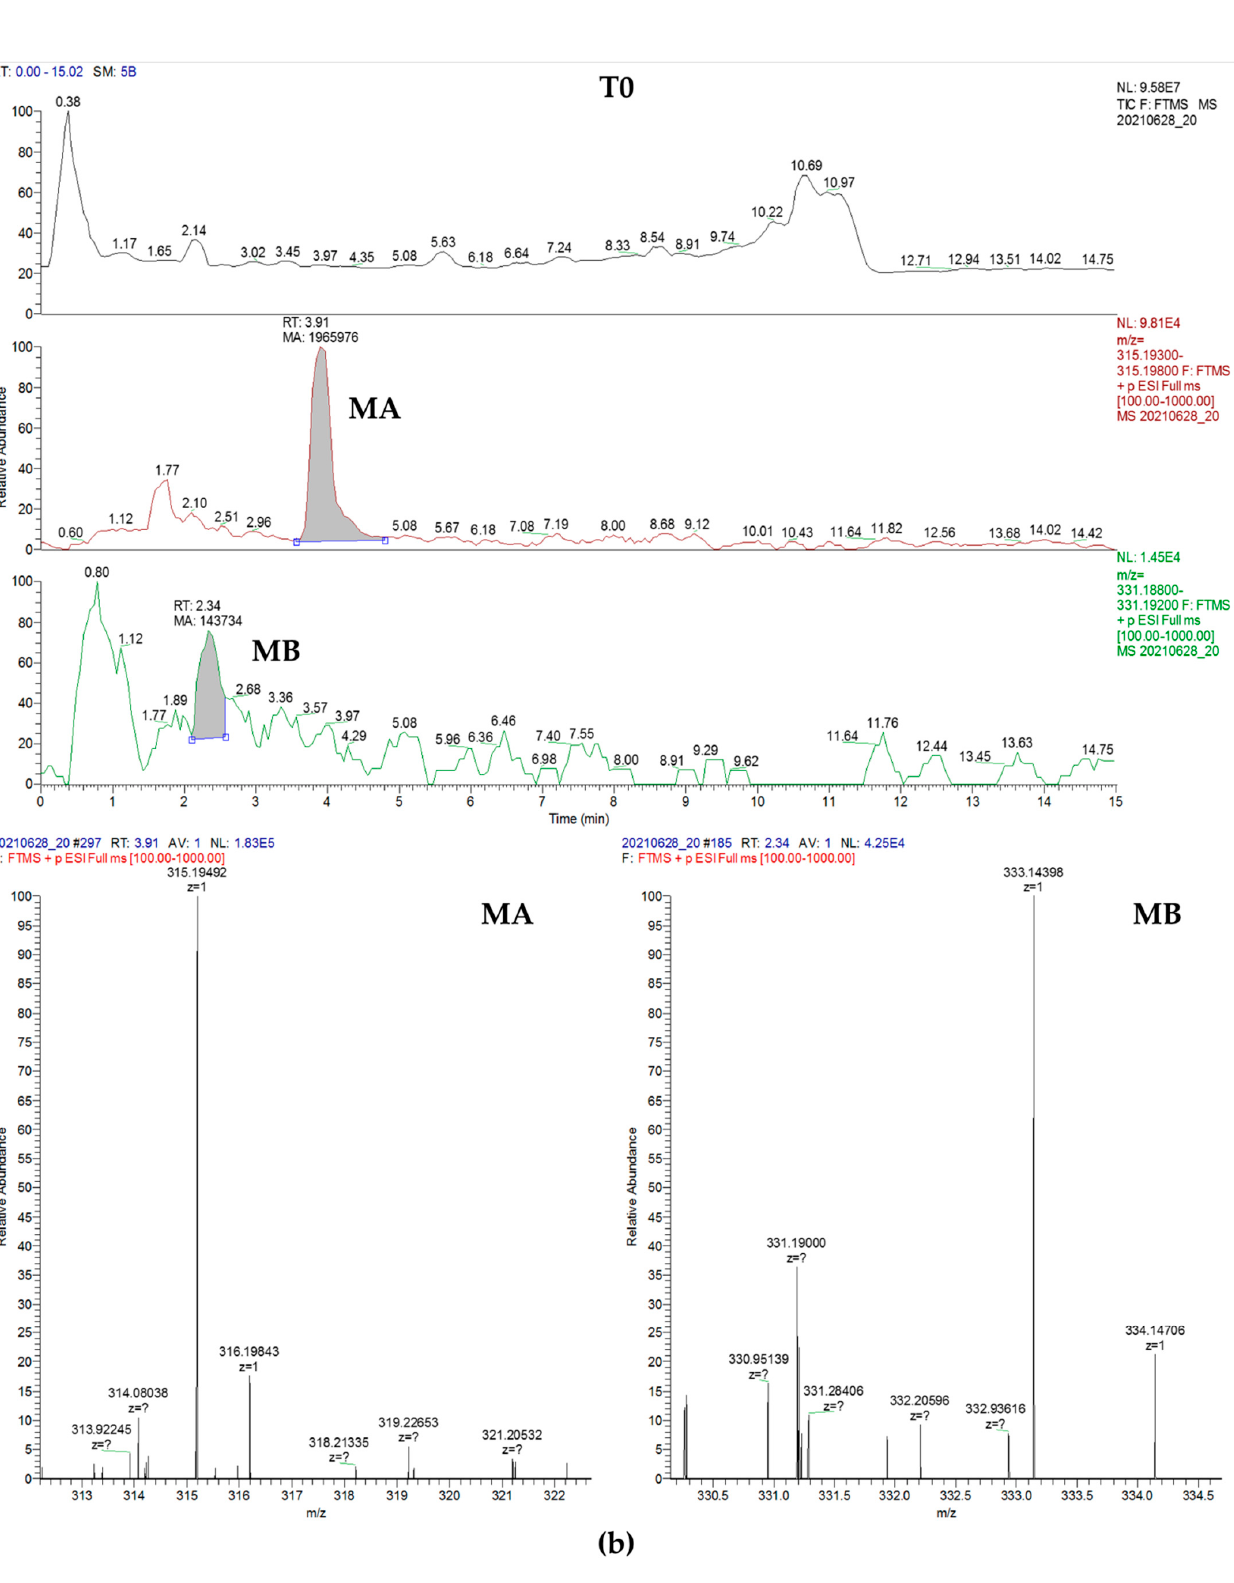
Figure 3. Ultra-performance liquid chromatography chromatograms and mass spectra of momilactones A (MA) and B (MB) standards ( a ); and MA and MB in T0 sample (BC15-Control) ( b ).